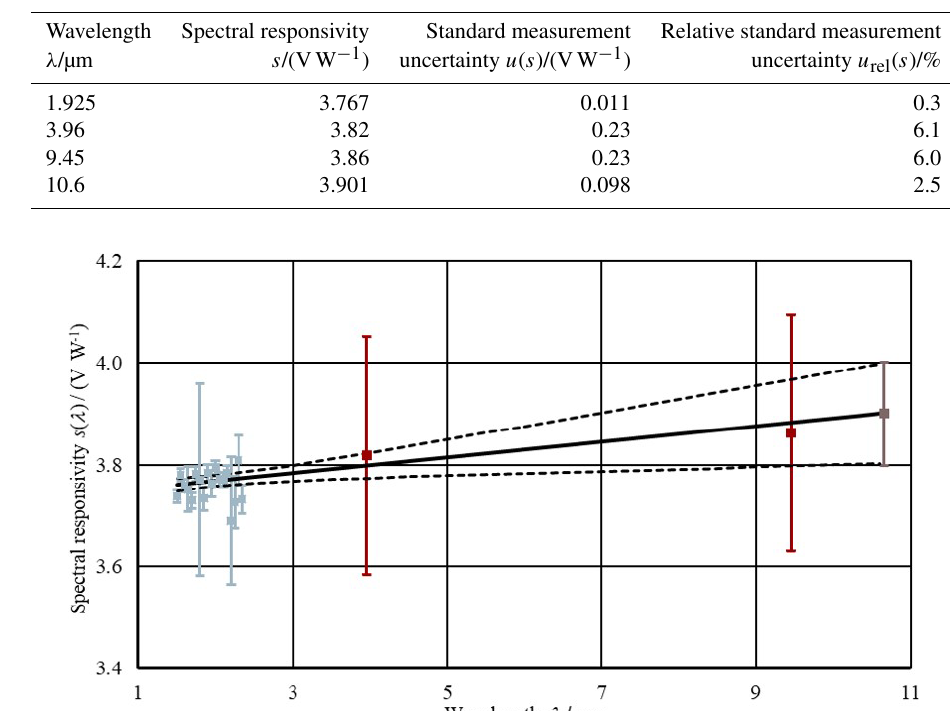
Figure 7. Spectral responsivity of the TS-76 in the MIR: absolute calibrations with a supercontinuum laser in the range 1.5 to 2.4µm and a CO 2 laser at 10.6µm have been used as supporting points for a linear interpolation. The interpolation is consistent with further absolute calibrations with a QCL at 3.96 and